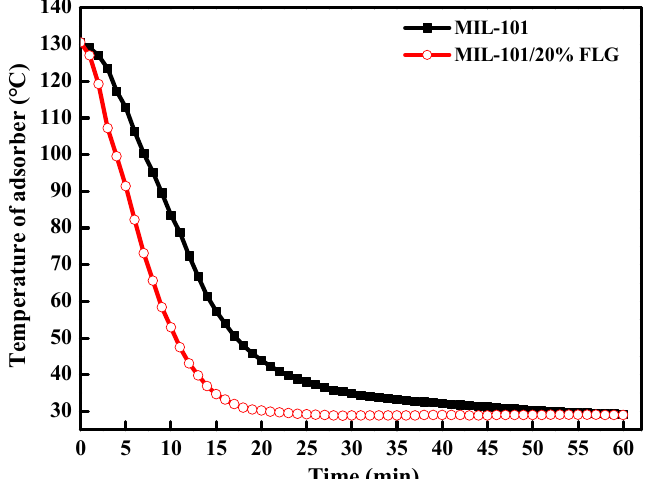
Figure 6. Temperature characteristic curves of MIL-101/20%FLG and MIL-101 adsorbers during the cooling process.